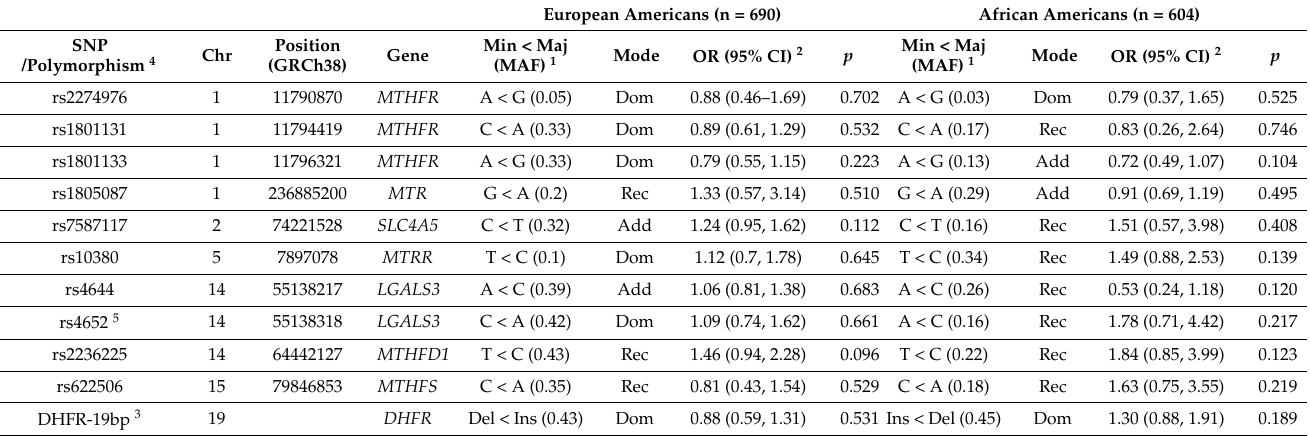
Table 3. Individual SNPs associated with prostate cancer aggressiveness by